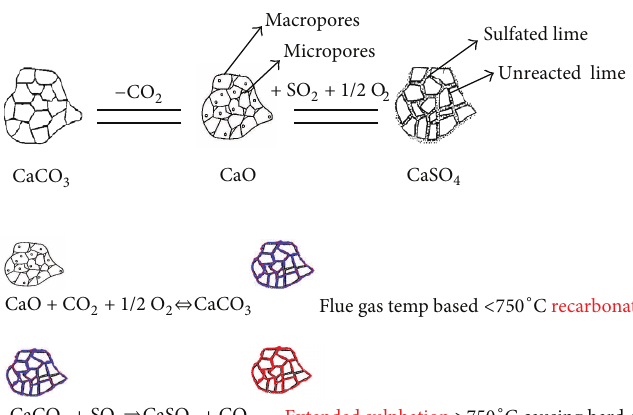
Figure 5: Consolidation mechanisms—sulfation of free